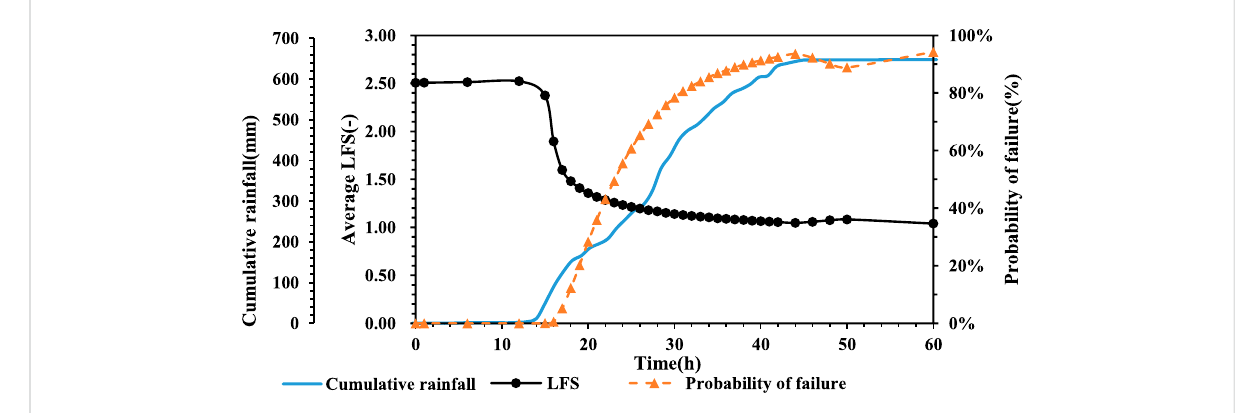
FIGURE 7 Temporal variation in accumulation rainfall, fuzzy weighted average LFS and probability of failure at observation point.